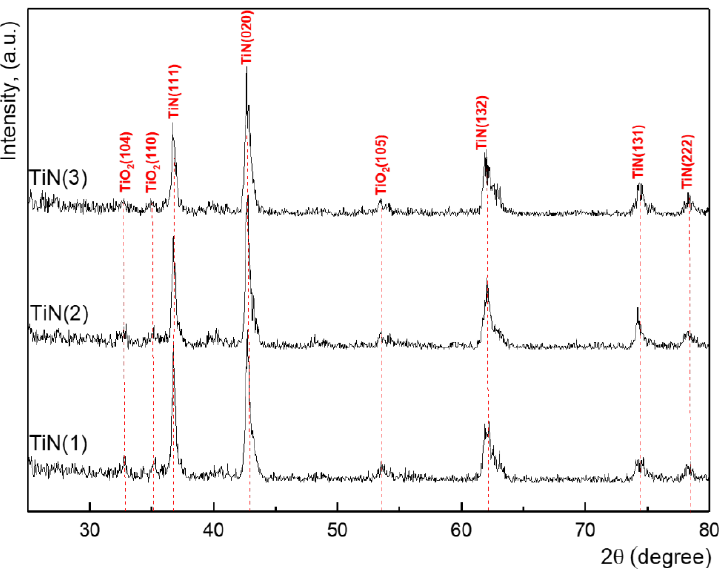
Figure 6. Diffractograms of TiN coatings.